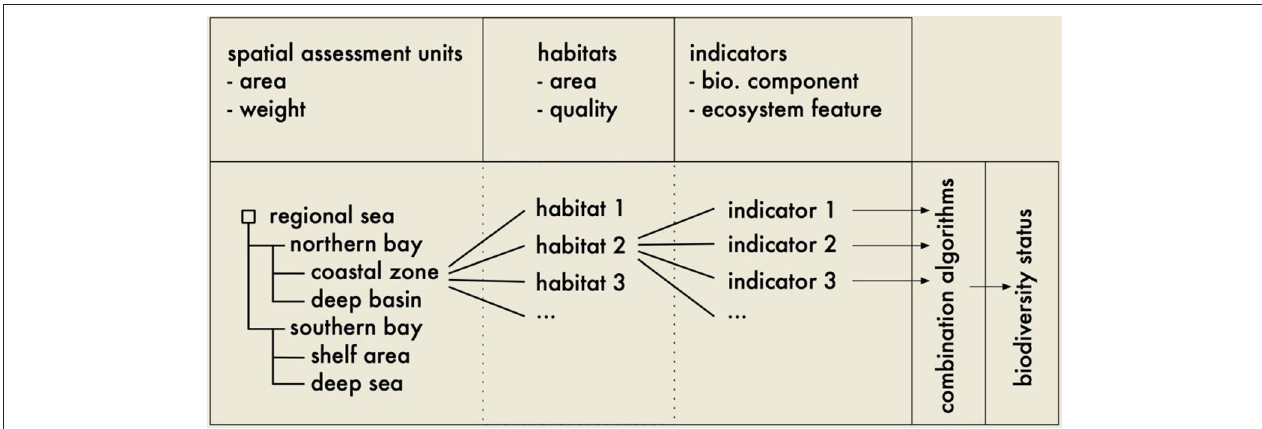
FIGURE 8 | Conceptual model of the design of the Nested Environmental Assessment Tool (NEAT). Every Spatial Assessment Unit (SAU) may be assigned to several habitats, every SAU/habitat combination to several indicators. SAUs and habitats are characterized by their area and a weight/quality while indicators are assigned to biodiversity components or other ecosystem features. The subsequent algorithms combine the indicator values using the weighting of their corresponding SAUs and habitats and result in the overall biodiversity status.